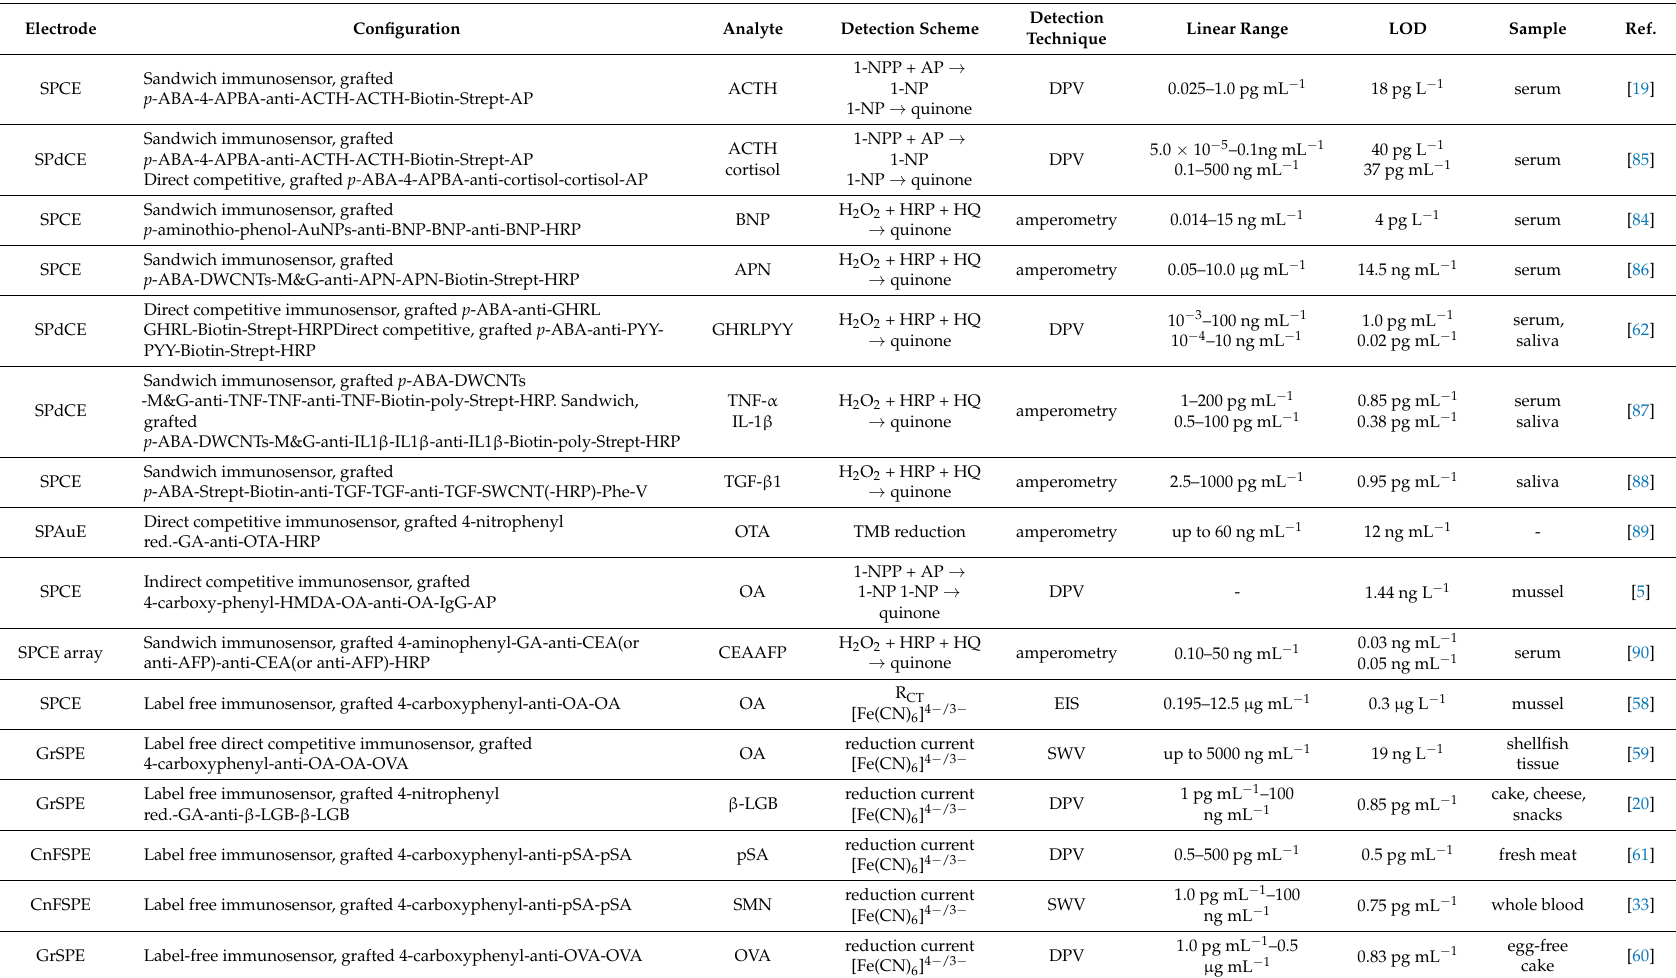
Table 1. Electrochemical affinity biosensors involving aryldiazonium salt chemistry onto screen printed